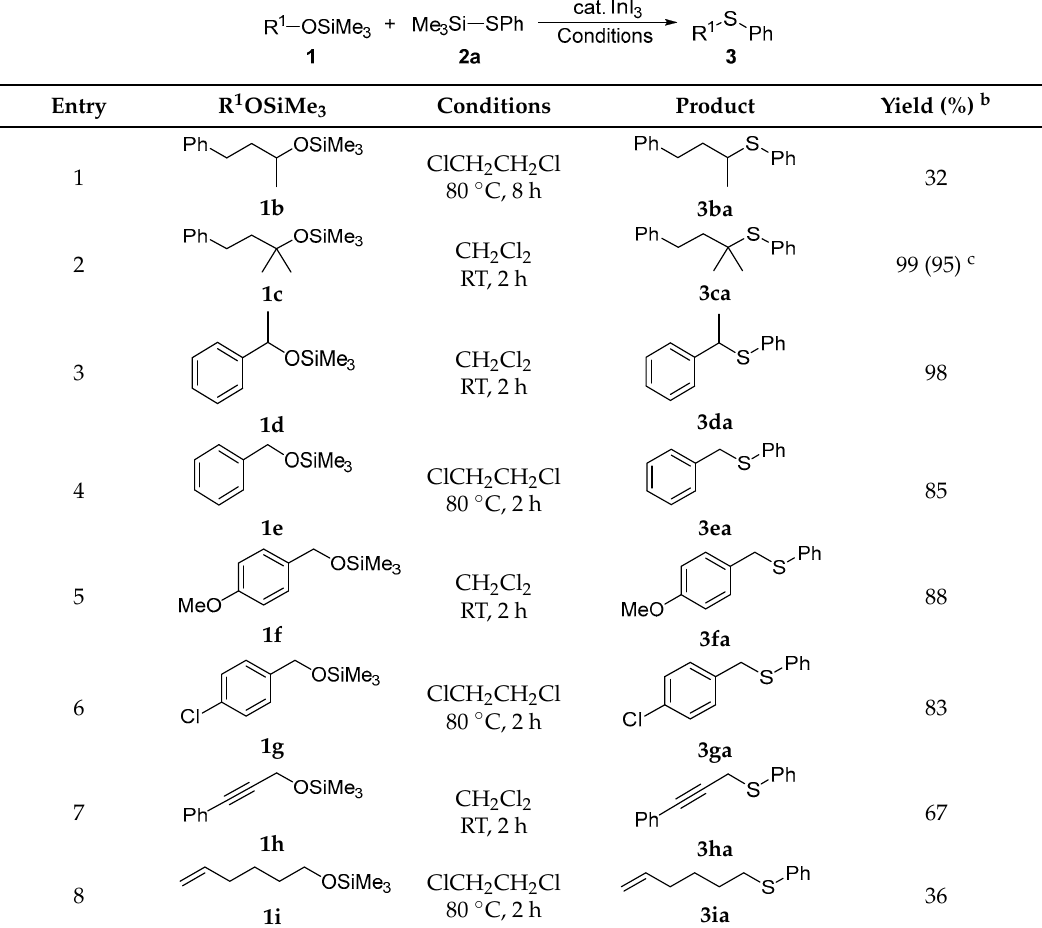
Table 2. Scope of the silyl ethers 1b–i in the InI 3 -catalyzed substitution reaction using thiosilane 2a . a